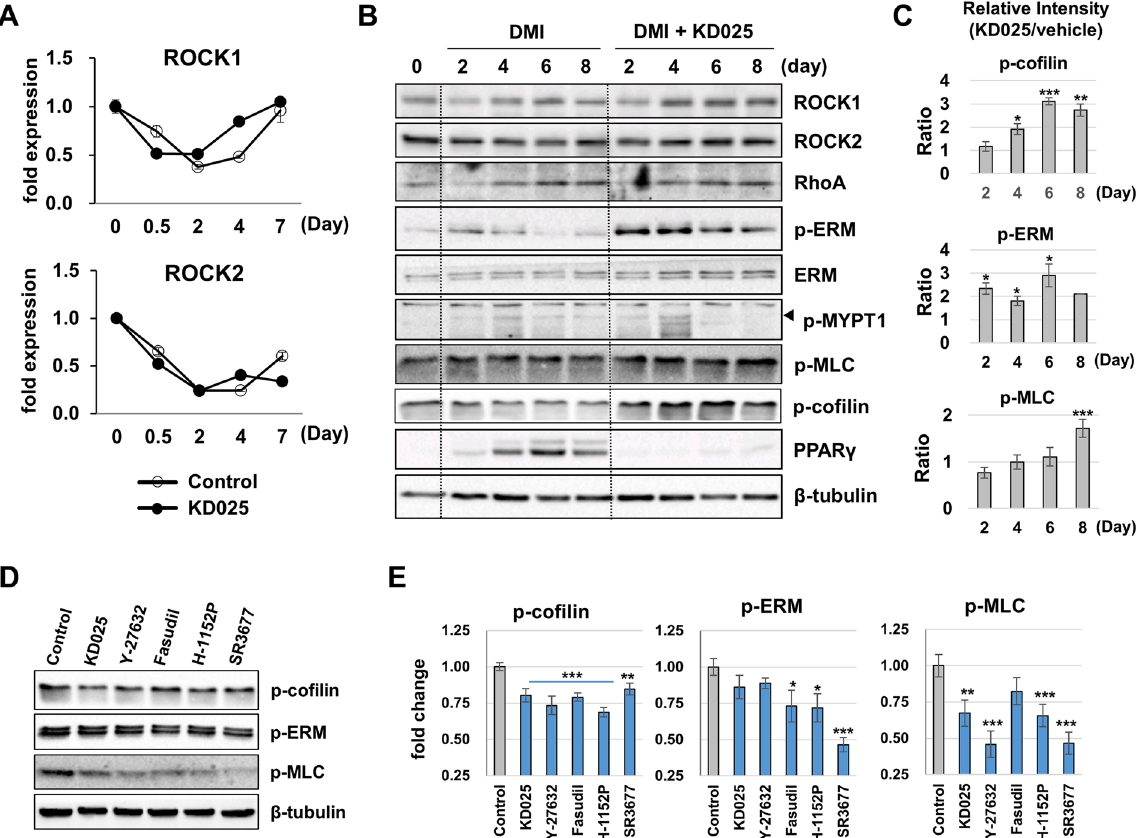
Figure 6. Regulation of ROCKs during adipogenesis. ( A – C ) 3T3-L1 cells were differentiated through incubation in DMI with or without KD025 for the indicated time points. ( A ) mRNA expression levels of ROCK1 and ROCK2 were measured by qRT-PCR. ( B ) Protein expression levels of ROCK1, ROCK2, p-cofilin, p-MLC, p-MYPT1, p-ERM, ERM and RhoA were analyzed by immunoblot. PPAR γ was used as a marker of adipogenesis and β -tubulin as a loading control. ( C ) The relative intensity of phosphorylation levels of cofilin, ERM, and MLC were compared between vehicle- and KD025-treated conditions. * p < 0.05; ** p < 0.01; *** p < 0.001 vs . the corresponding control. ( D , E ) 3T3-L1 pre-adipocytes were treated with KD025 (7 µ M), Y-27632 (10 µ M), fasudil (10 µ M), H-1152P (3 µ M), or SR3677 (5 µ M) for one day. The phosphorylation levels of cofilin, ERM, and MLC were measured by immunoblot. β -tubulin was used as a loading control. * p < 0.05; ** p < 0.01; *** p < 0.001 vs . vehicle-treated. The data are the representative from more than three independent experiments. Data are expressed as means ± S.E. based on